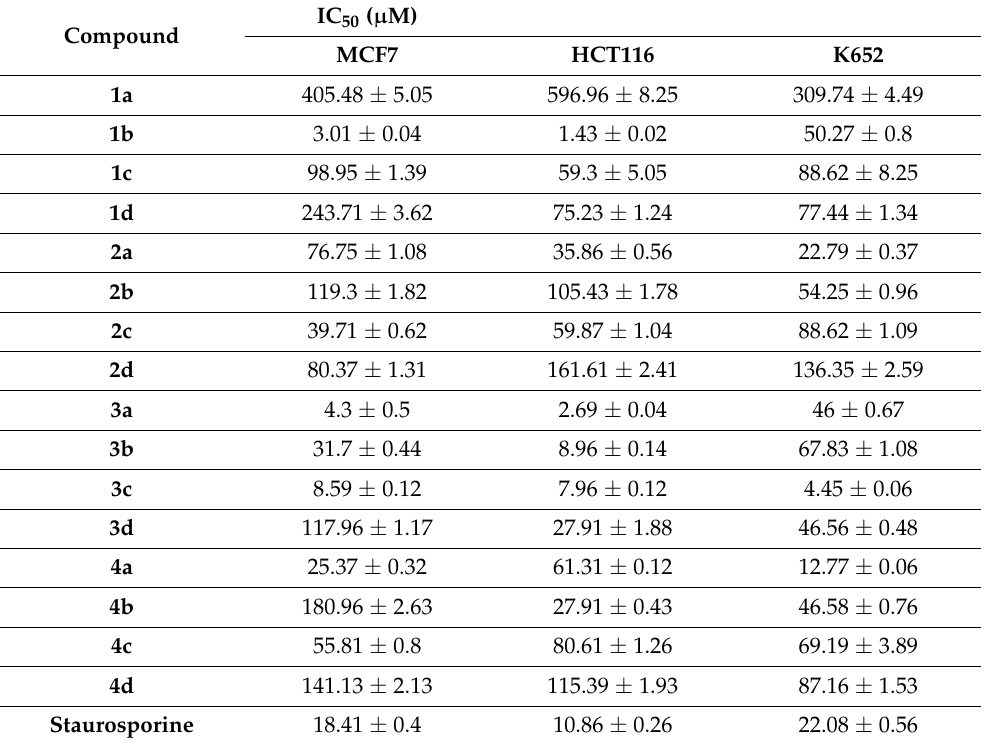
Table 2. Cytotoxicity effect of compound 1 – 4 in MTT assay. Data are presented as means ± standard deviation of three individual experiments.